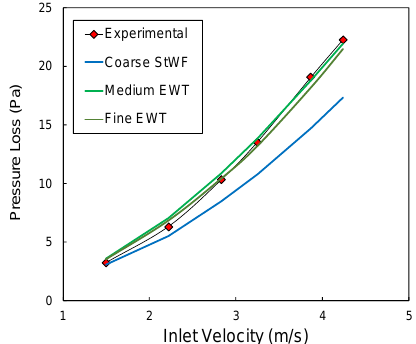
Fig. 3. Pressure loss vs. inlet velocity for different